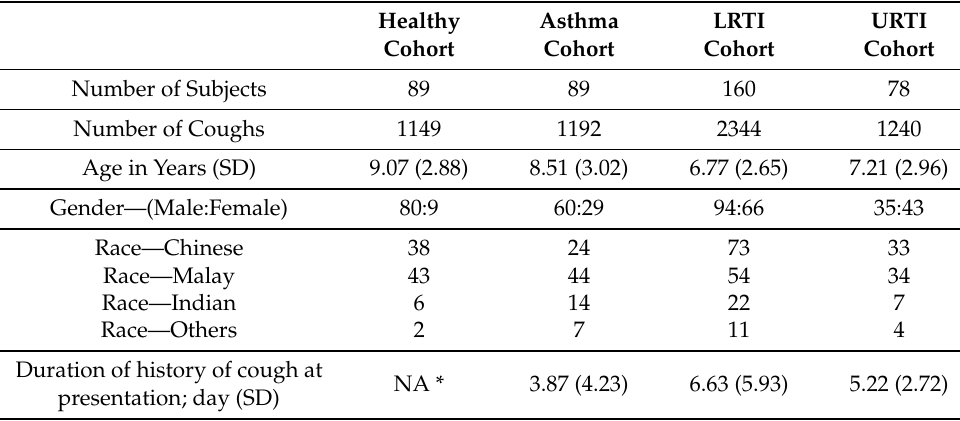
Table 1. Characteristics of the collected cough